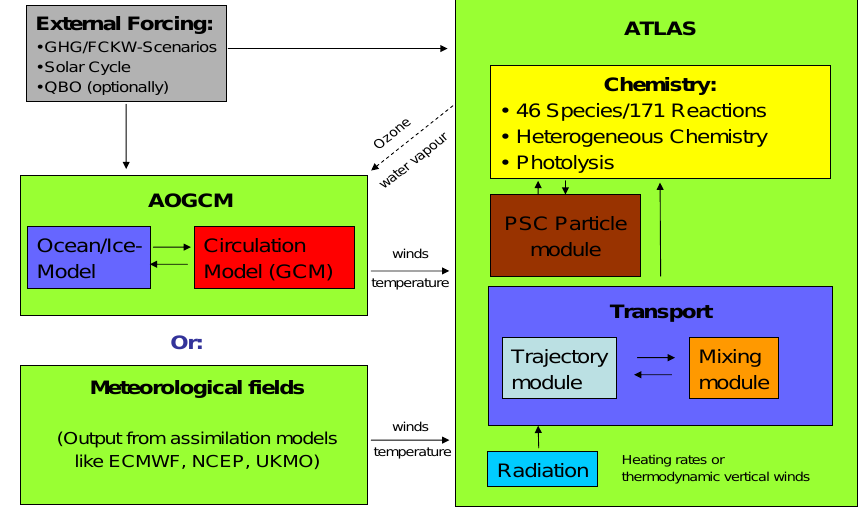
Fig. 1. Model concept.